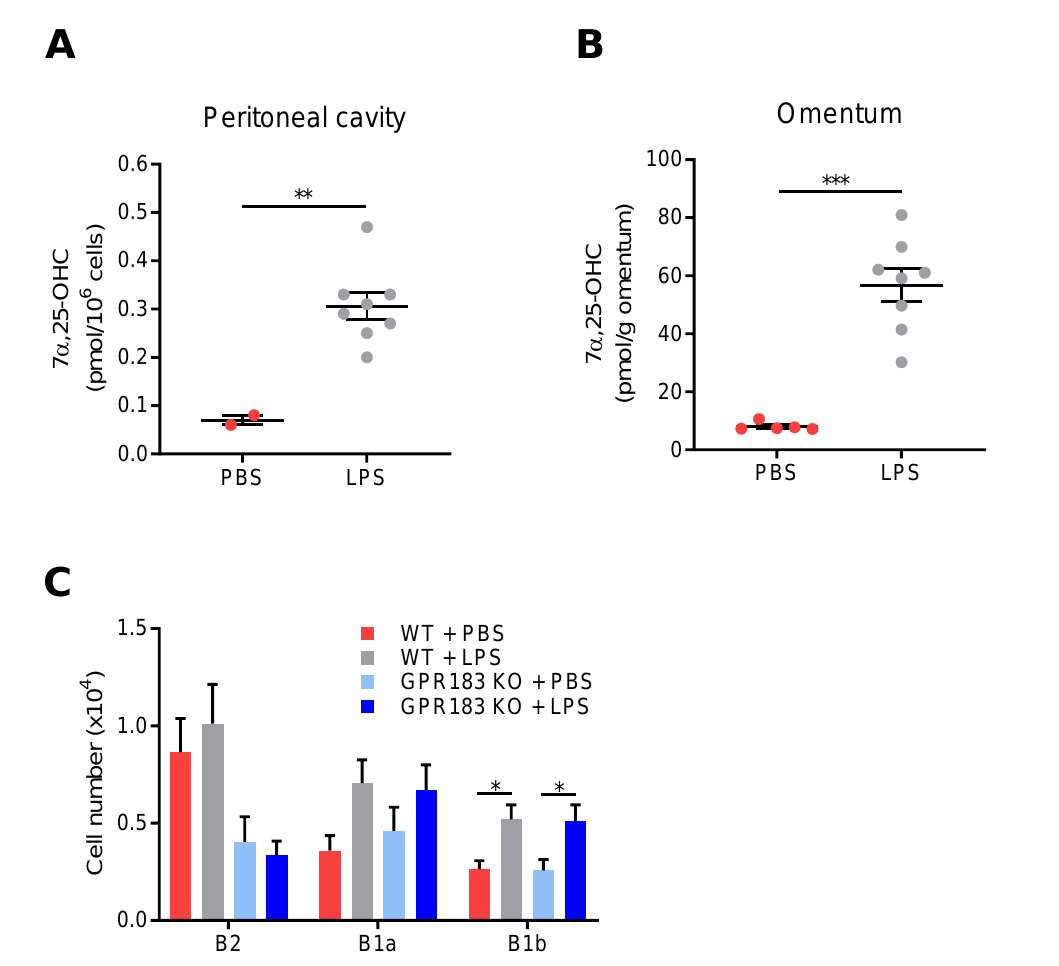
Figure 4. Omentum and milky spots in GPR183 KO mice; ( A ) whole omenta from WT (left) and GPR183 KO (right) mice stained with an anti-B220 antibody (red) and a Hoechst nuclear stain (blue) and imaged by fluorescence confocal microscopy. The insert shows a magnification of a single milky spot; ( B ) quantification of the total surface area of omenta from 7 10–14 weeks old WT and GPR183 KO mice; ( C ) quantification of the total area per omentum that constitutes milky spots, in the same omenta as in ( B ). The data were pooled from two independent experiments. Error bars represent mean ± SEM. * p < 0.05 by unpaired Student’s t -test.